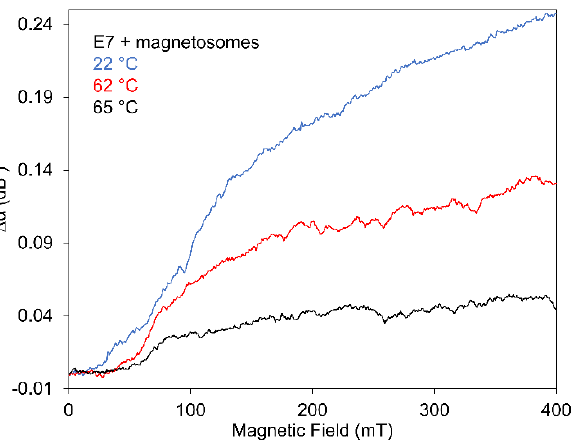
Figure 8. Comparing of the effect of magnetic field on SAW attenuation for E7 doped with magne- tosomes of concentrations of 0.2 wt% for three temperatures around T NI (60 °C).